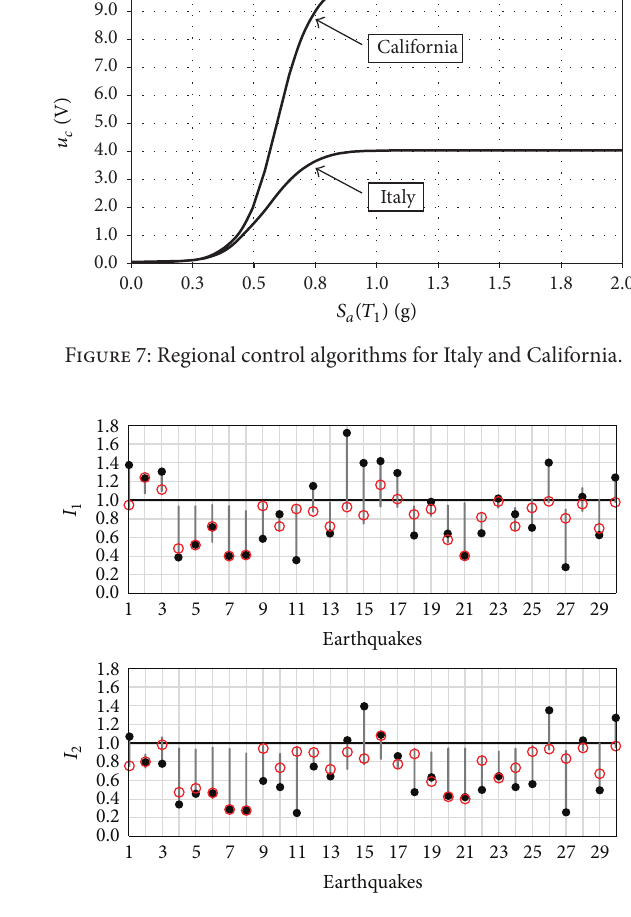
Figure 8: Italy: performance indices for the smart passive strategy (red circles) compared to the pure passive ones (black